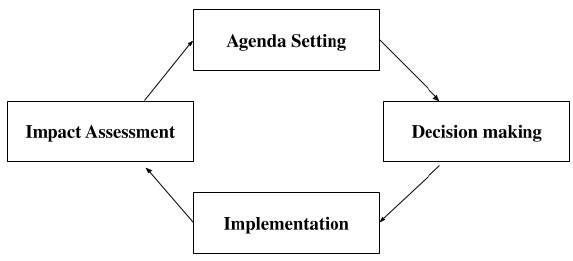
Figure 1: The standard policy